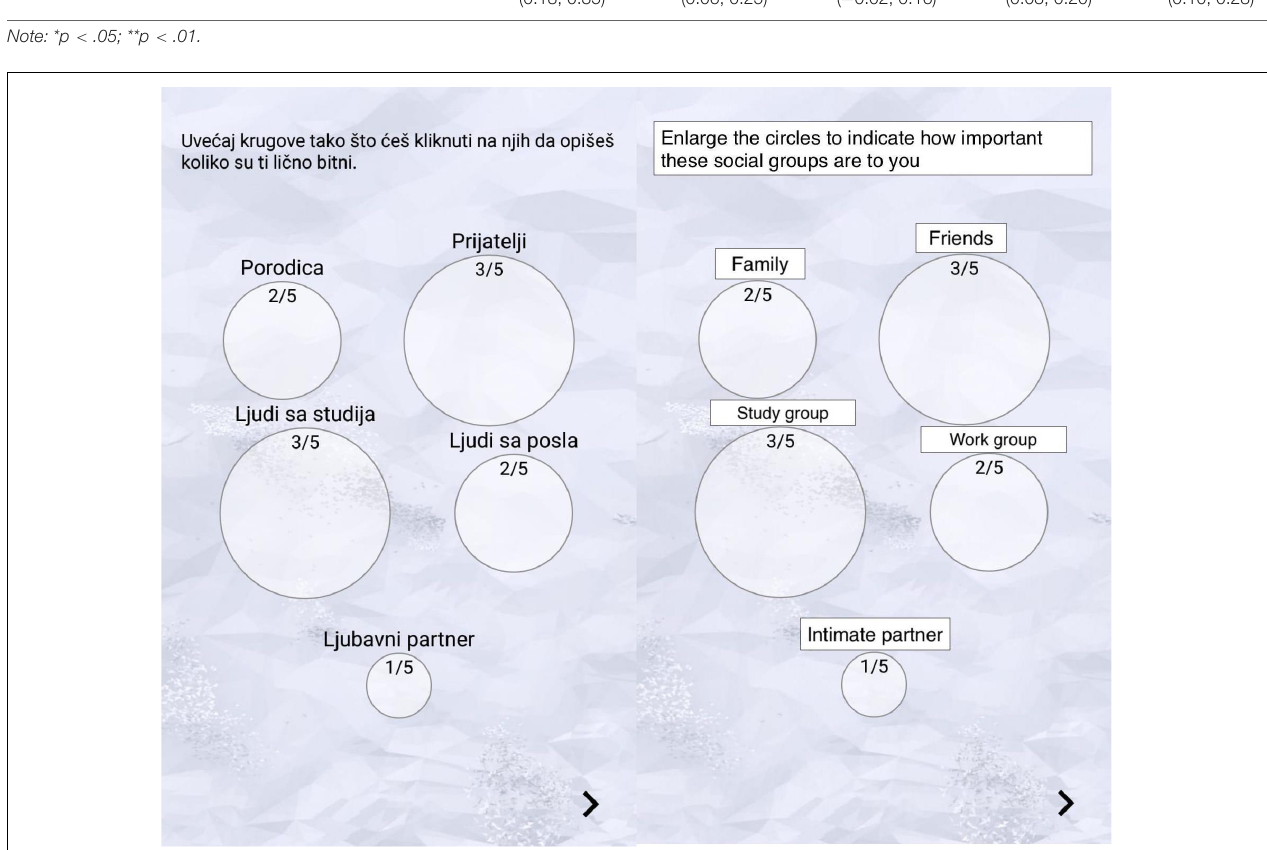
FIGURE 6 | Response format used by the app (in Serbian and in its English